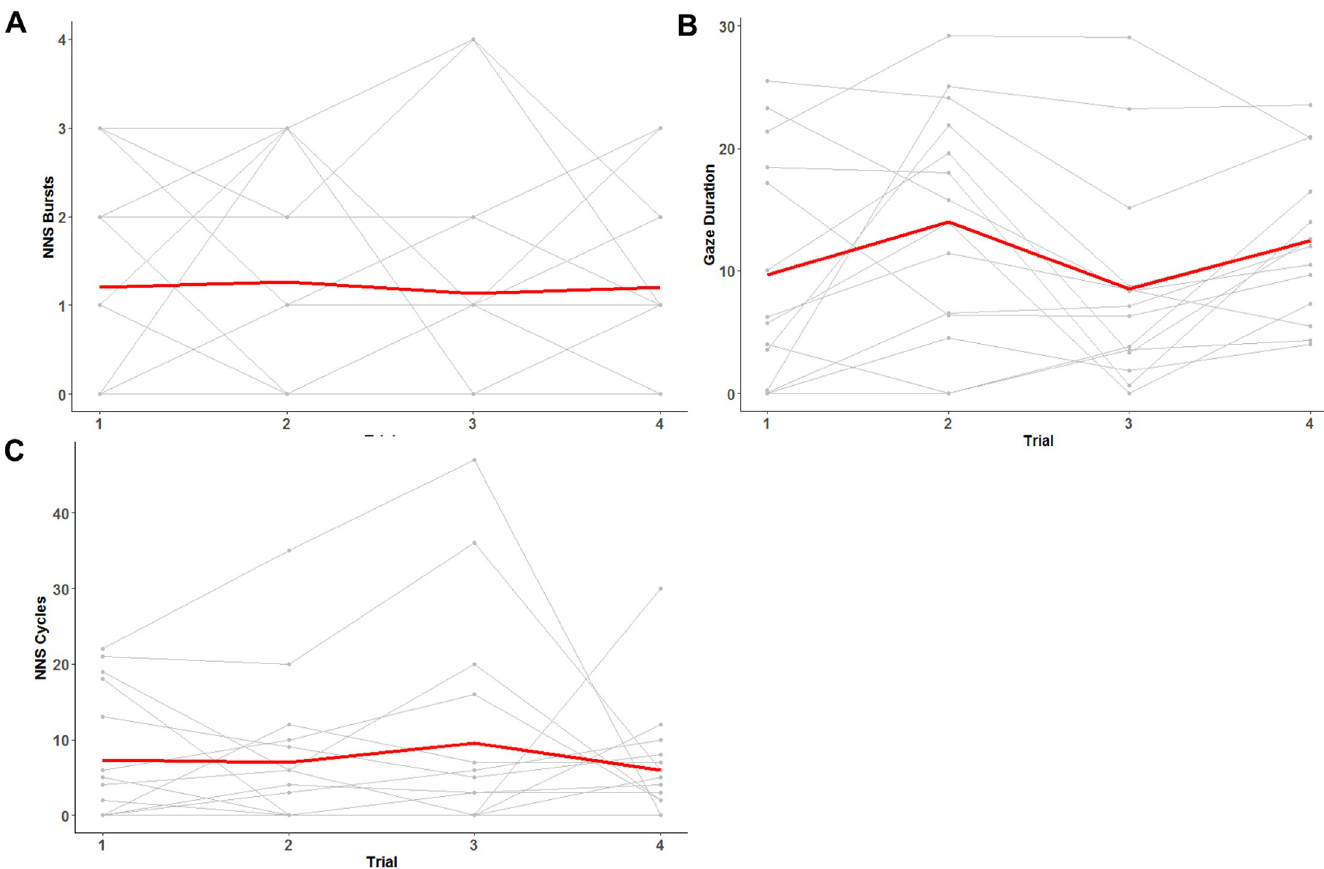
Fig 4. Spaghetti plots for NNS Bursts (A), Gaze Duration (B), and NNS cycles (C) across trials. Each infants’ data is in light gray and the average is shown in dark